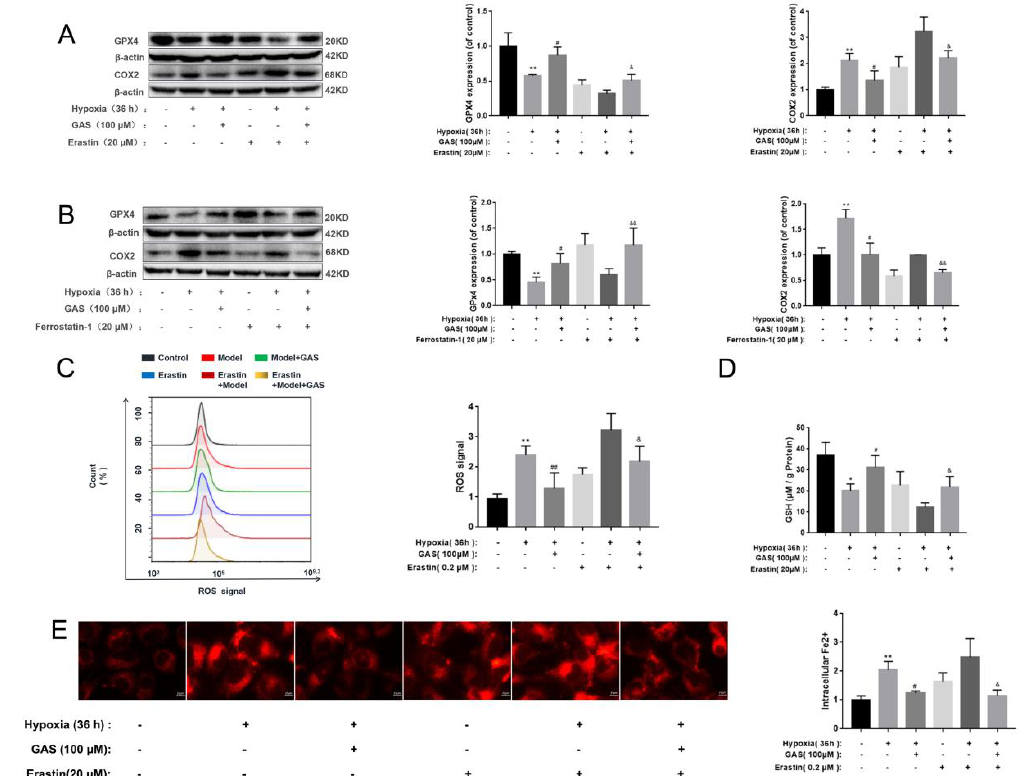
Figure 4. Experimental study on the improvement of hypoxic injury of HT22 cells by GAS based on the regulation of ferroptosis by the GPx4 pathway. ( A , B ), GPx4 and COX2 were analyzed using Western blot. Pharmacological inhibitors; erastin (ferroptosis inducers), ferrostatin-1 (ferroptosis inhibitor) ( C ), intracellular ROS levels were labeled with 2,7-Dichlorodihydrofluorescein diacetate (DCFH-DA, 10 µ M) and detected by flow cytometry ( n = 3) ( D ), levels of GSH in HT22 cells treated with ferroptosis inducers (erastin) were detected with or without GAS treatment (100 μM) for 24 h ( n = 3) ( E ), detection of intracellular Fe 2+ changes using FerroOrange. * p < 0.05, ** p < 0.01 compared